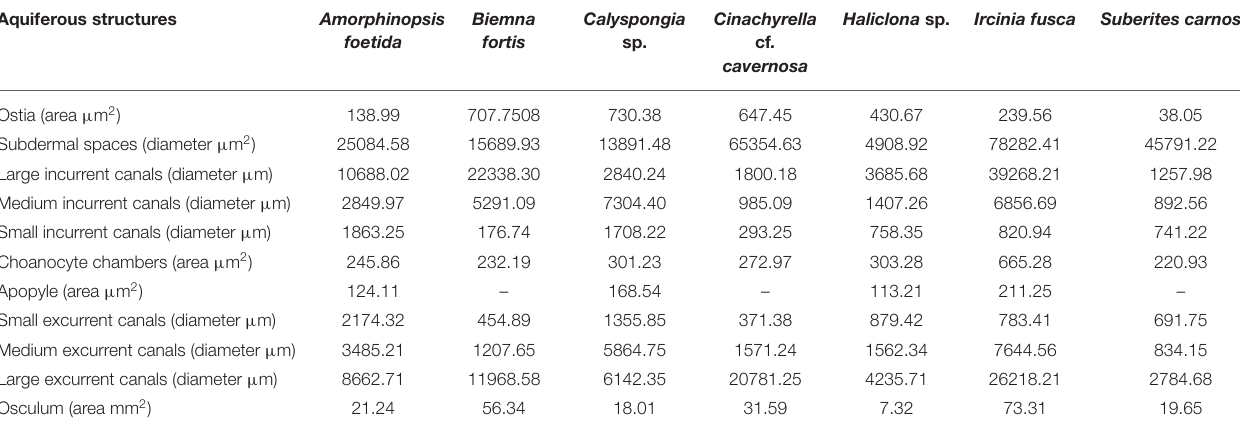
TABLE 5 | Dimensions of the components of the aquiferous system calculated from the SEM and histological images of the study species. Aquiferous structures